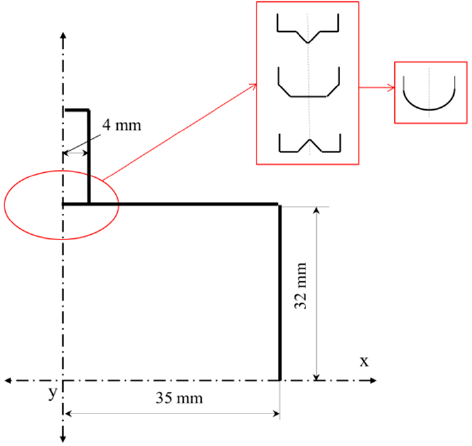
Figure 3. Dimensions and geometries (red frame) of the indentation process simulated.